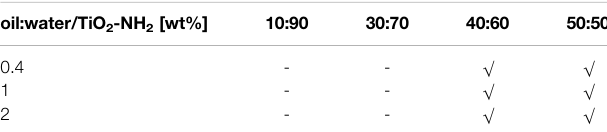
TABLE 1 | Composition of the